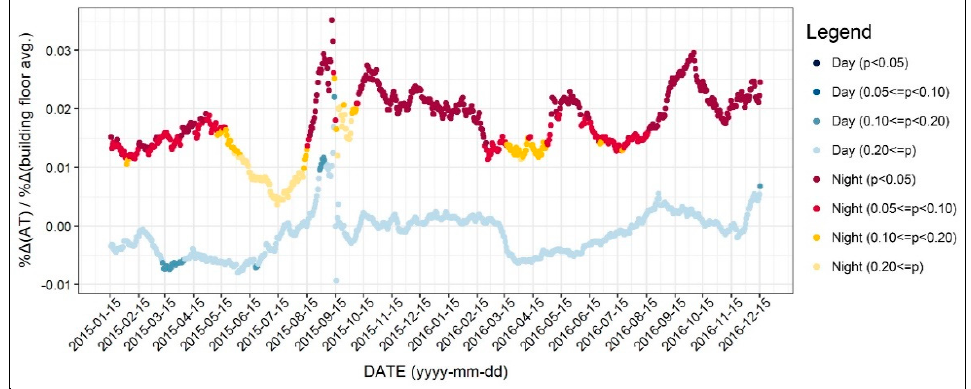
Figure 13. Changing patterns in the regression coefficients and their significances (building floor avg.).